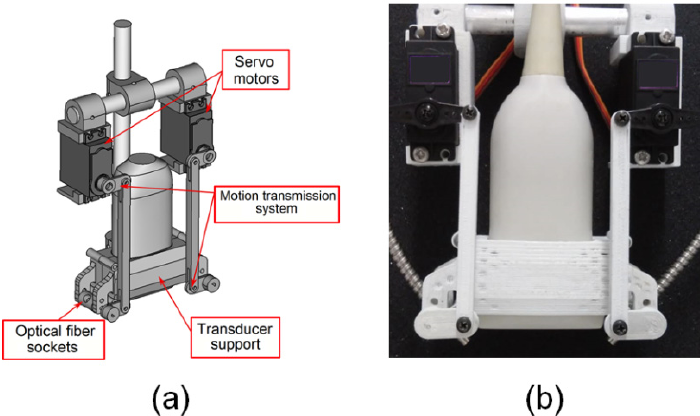
Figure 2. (a) Three-dimensional model and ( b ) prototype of the multiangle long-axis lateral illumination device attached to a linear array ultrasound transducer.